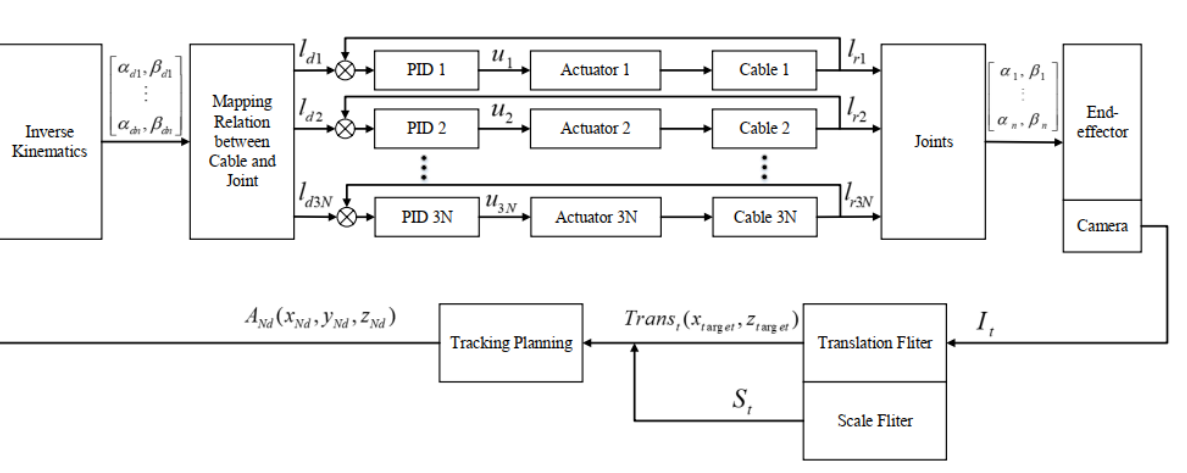
Figure 6. The control scheme of